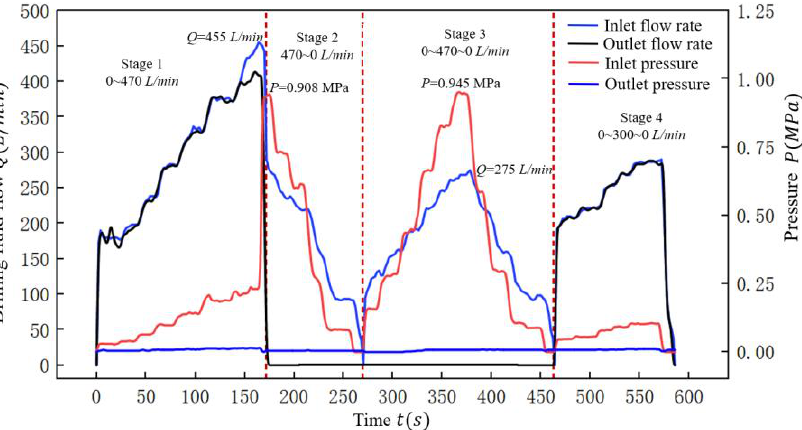
Figure 19. Drilling fluid flow and pressure of Experiment IV change with time.